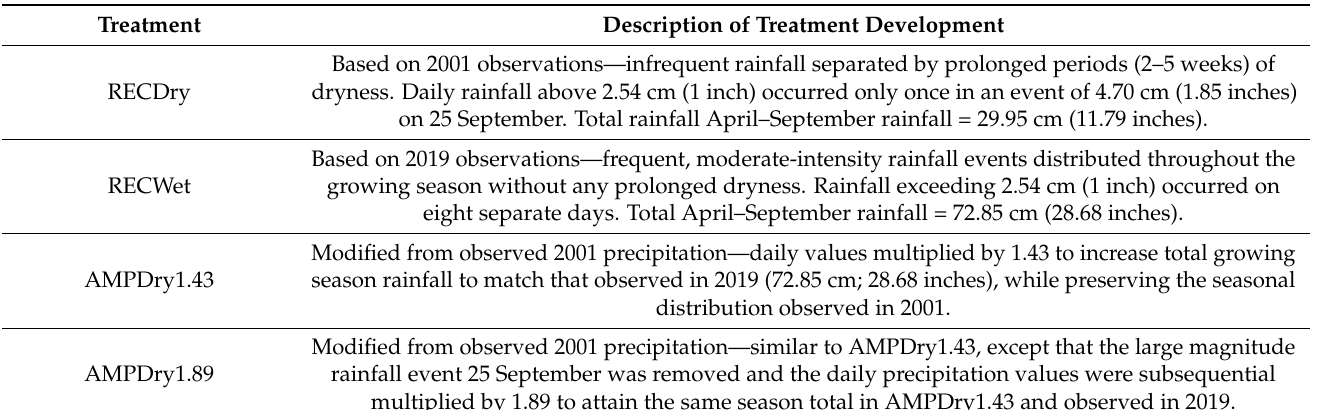
Table 1. Precipitation scenarios used as independent